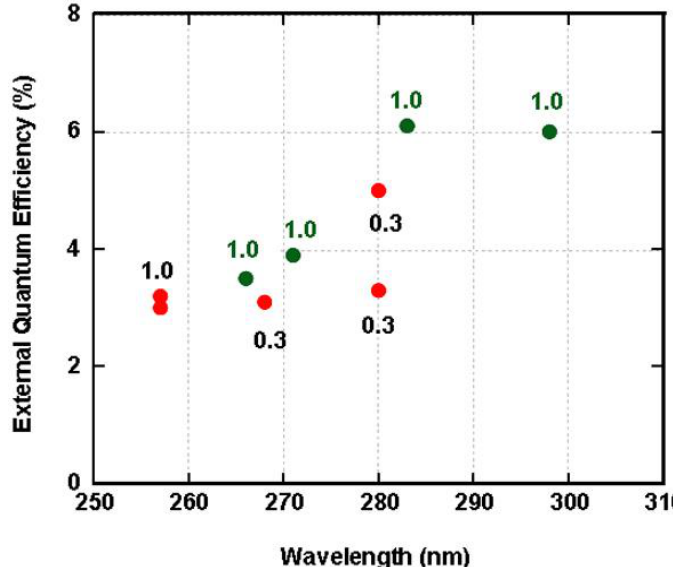
Figure 4. Our reported EQEs [13,37,38] for various miscut angles of the sapphire substrate. The EL output tends to increase in the case of using high-miscut sapphire. (Permitted to be reused from Jpn. J. Appl. Phys. [13]. © Japan Society Applied Physics). Appl. Phys. [13]. © Japan Society Applied